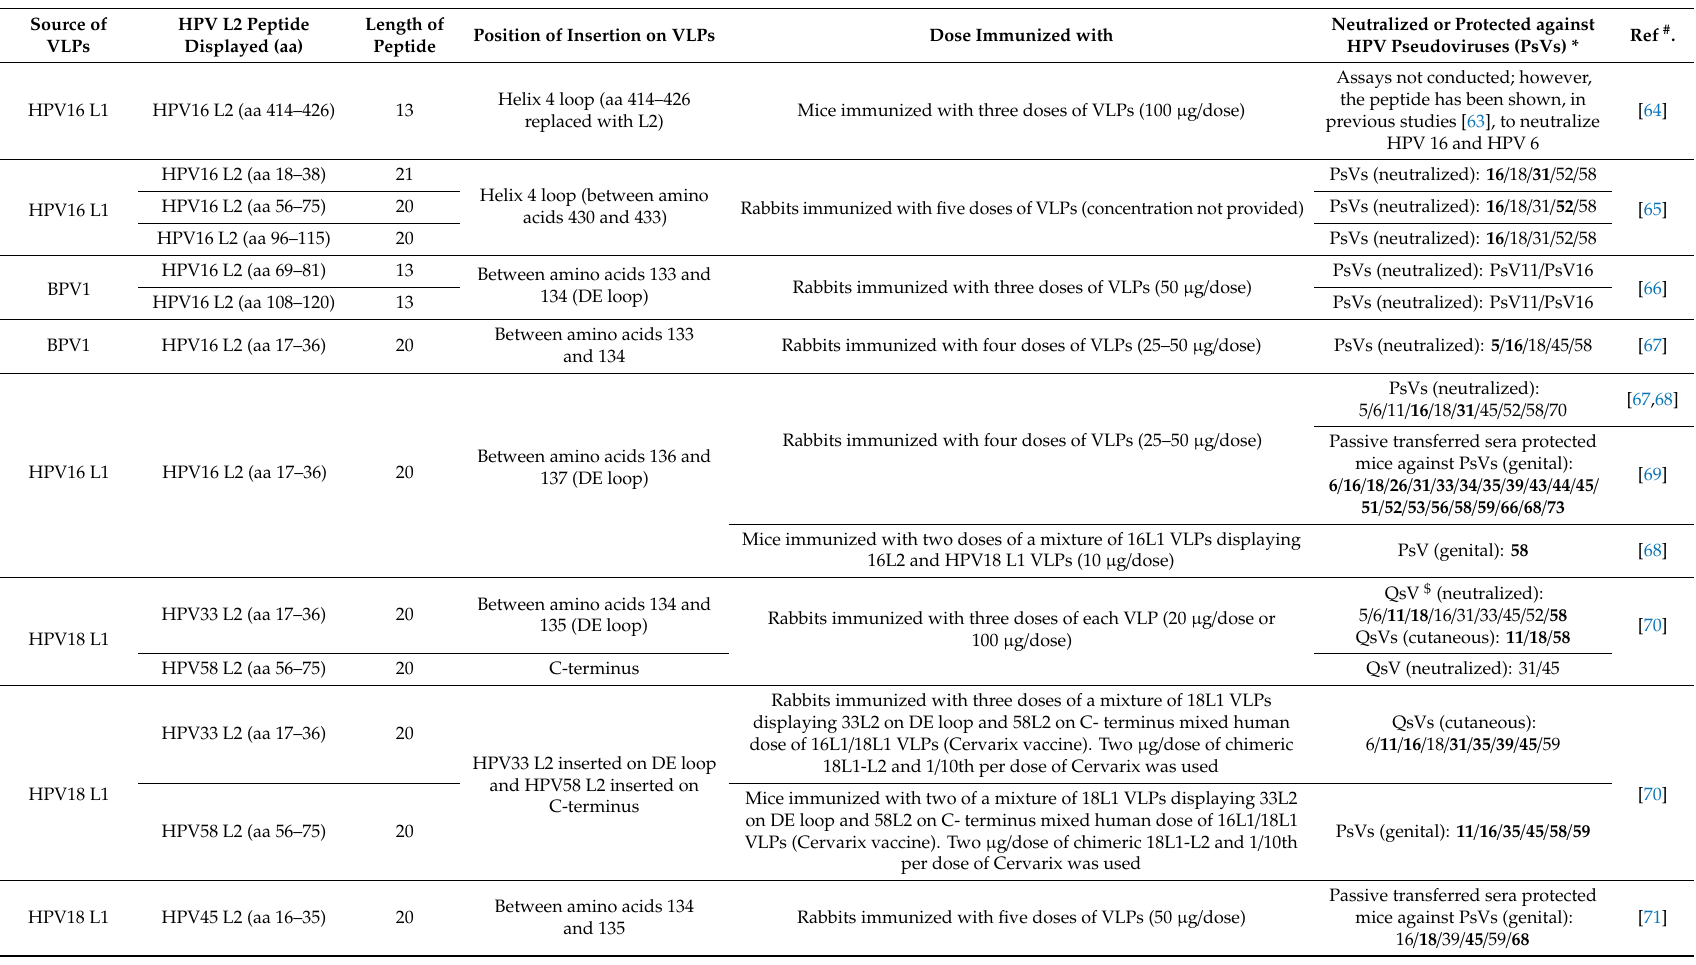
Table 2. Candidate eukaryotic VLP-based L2 HPV